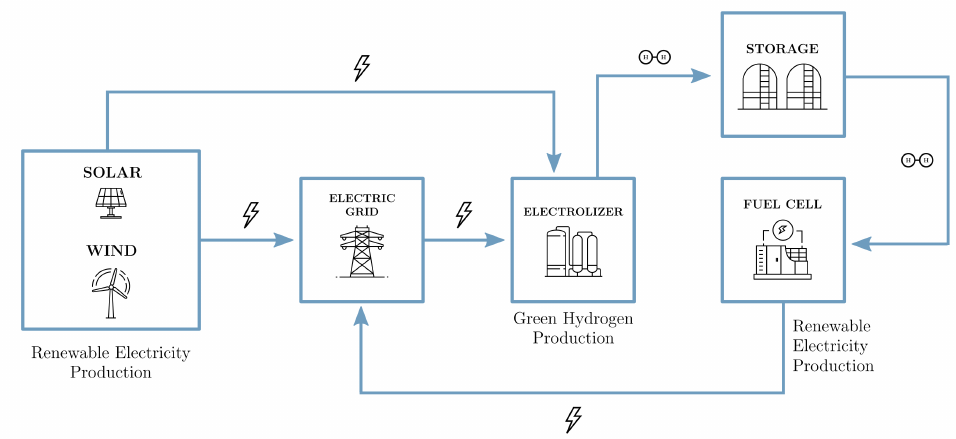
Figure 12. Flowchart of a power-to-power hydrogen value chain configuration. Adapted from